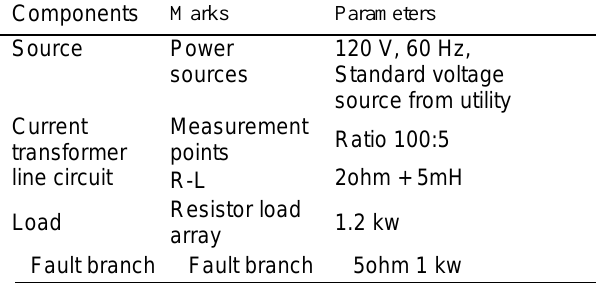
Table 2. Test-bed parameters